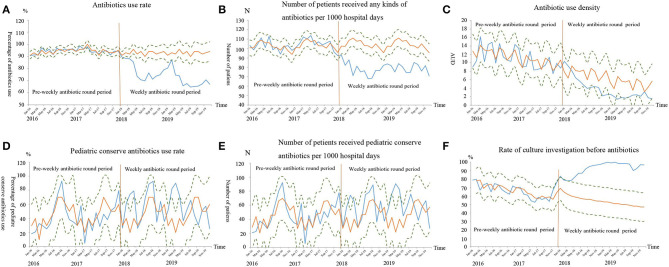
The antibiotics consumptions after time series forecasting. The blue curve was the observed values curve from January 2016 to December 2019, the yellow curve was the predicted time-series values curve based on the data from January 2016 to December 2017, and the dots curves were the upper/lower level of 95% confidence interval of the predicted curve. The orange vertical line indicated the starting time of the weekly antibiotic round. The observed values curve for antibiotics use rates (A), number of patients who received any kind of antibiotic per 1,000 hospital days (B), antibiotic use density (C), had an overall decreasing trend from January 2016 to December 2019, but were progressively lower than the predicted values curve from January 2018 to December 2019 (P < 0.01). The pediatric conserve antibiotics rates (D) and number of patients who received pediatric conserve antibiotics per 1000 hospital days (E) were not significantly different between the observed values curve and predicted time-series values curve (P > 0.05). The observed values curve for rate of culture investigation before antibiotics (F) had an overall increasing trend from January 2016 to December 2019, but were progressively higher than the predicted values curve from January 2018 to December 2019 (P < 0.01).